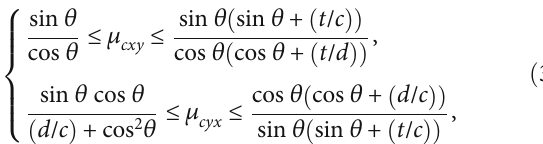
Figure 2: Loading diagram of three-point bending experiment.